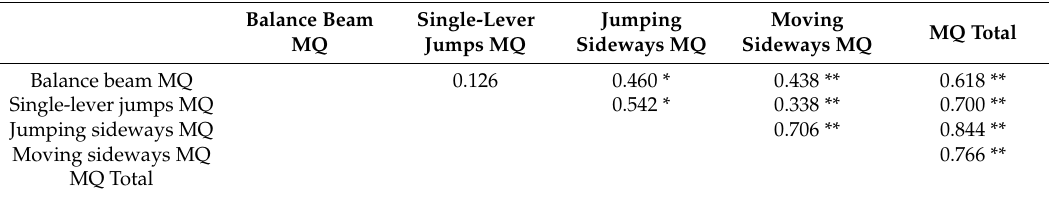
Table 4. The correlation matrix showing Pearson’s r for MQ variables.